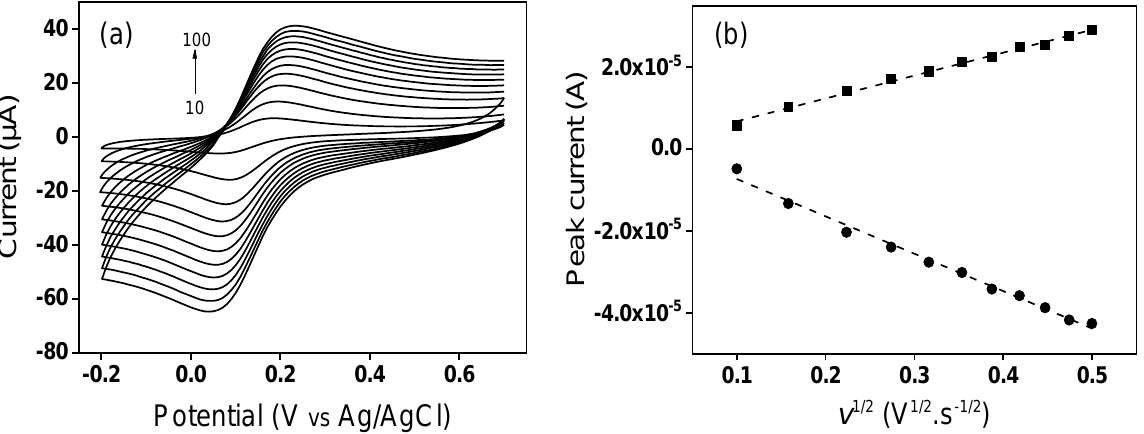
Figure 8. ( a ) Cyclic voltammograms at various scan rates (10 to 100 mV · s − 1 ) recorded in 0.1 M KCl containing 1 mM [Fe(CN) 6 ] 3 − on TalcNH 2 /GCE, and ( b ) linear plot of Ip (peak current) vs. v 1/2 .